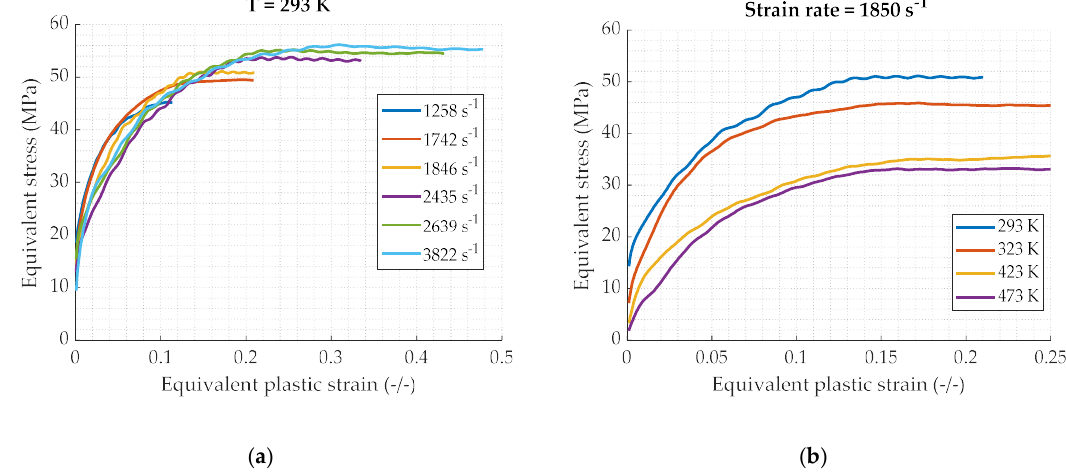
Figure 16. True plastic strain–true stress curves in dynamic compression loading: ( a ) at different strain rates and constant temperature of 293 K; ( b ) at different temperatures and constant strain rate of 1850 s −1 .